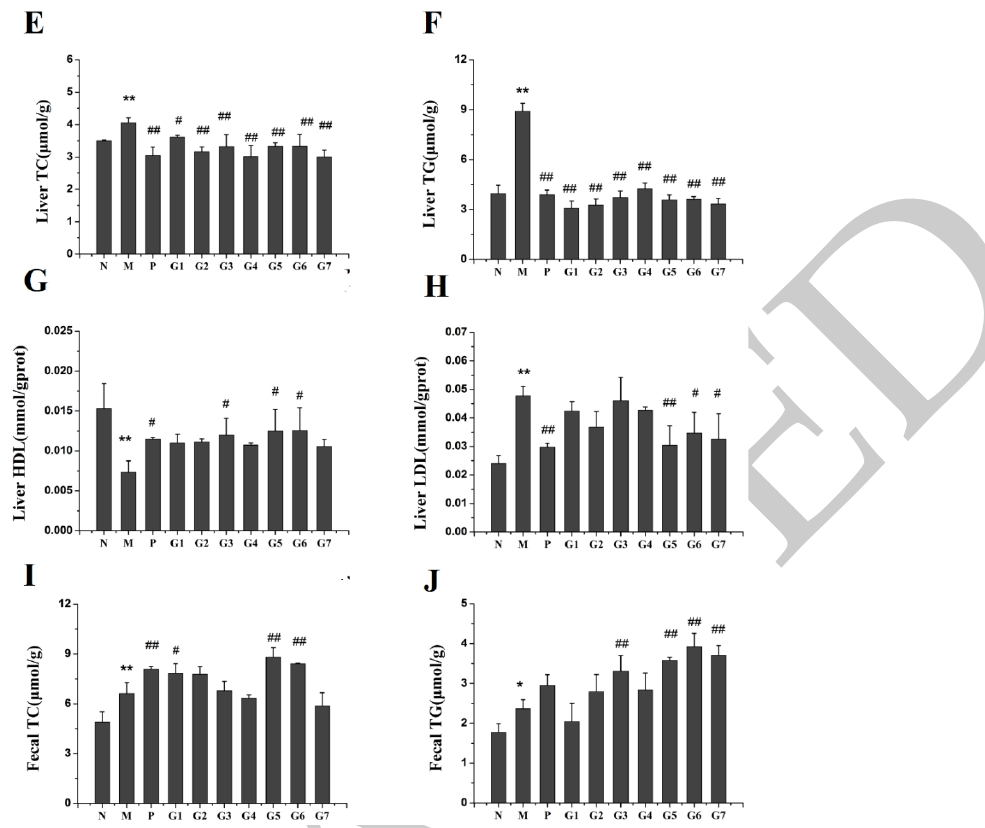
Figure 3. The effect of GA on lipid profile, including Serum TC ( A ); Serum TG ( B ); Serum HDL ( C ); Serum LDL ( D ); Liver TC ( E ); Liver TG ( F ); Liver HDL ( G ); Liver LDL ( H ); Fecal TC ( I ); Fecal TG ( J ).